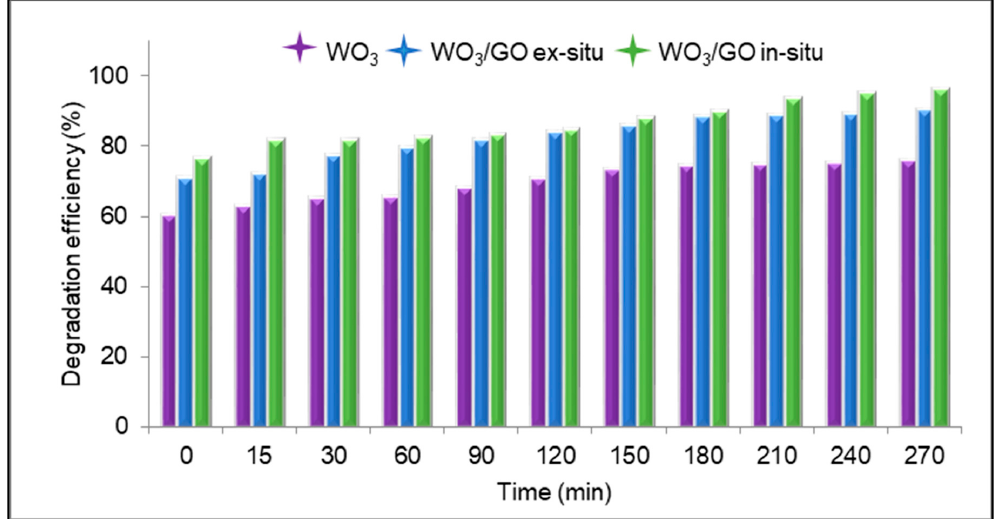
Figure 8. Degradation efficiency of MB.